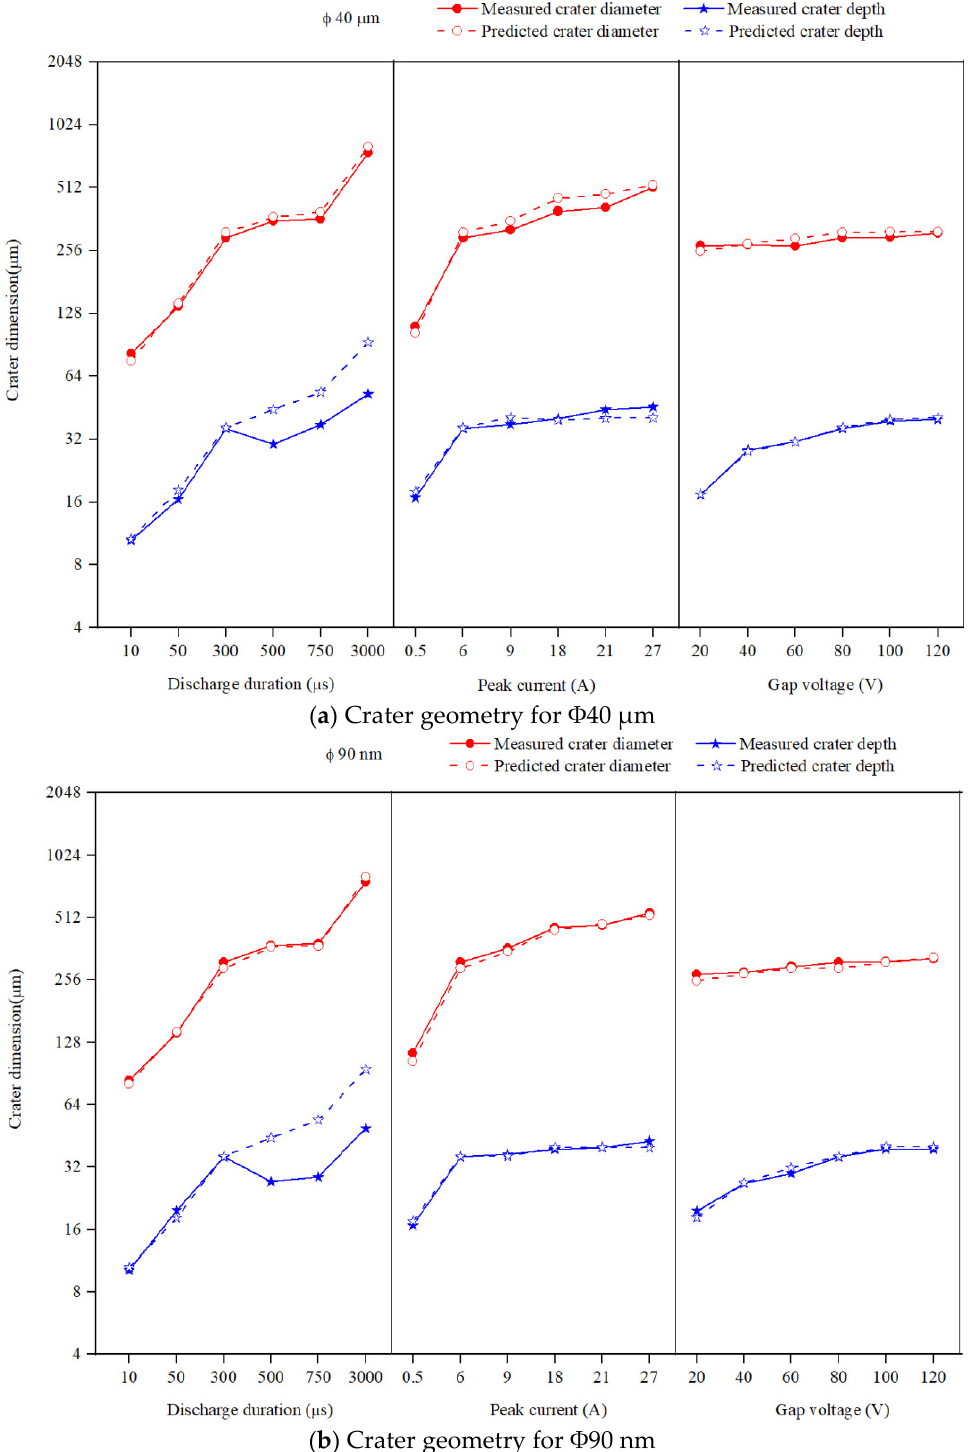
Figure 9. Effect of input process variables on crater geometry.